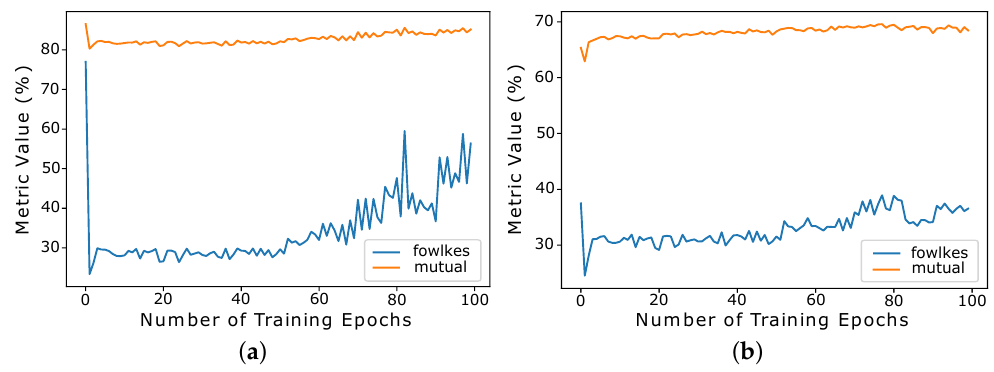
Figure 9. Performance evaluation of ELINAC for mutual info and Fowlkes–Mallows metrics. ( a ) spe- cific clusters and ( b ) generalist